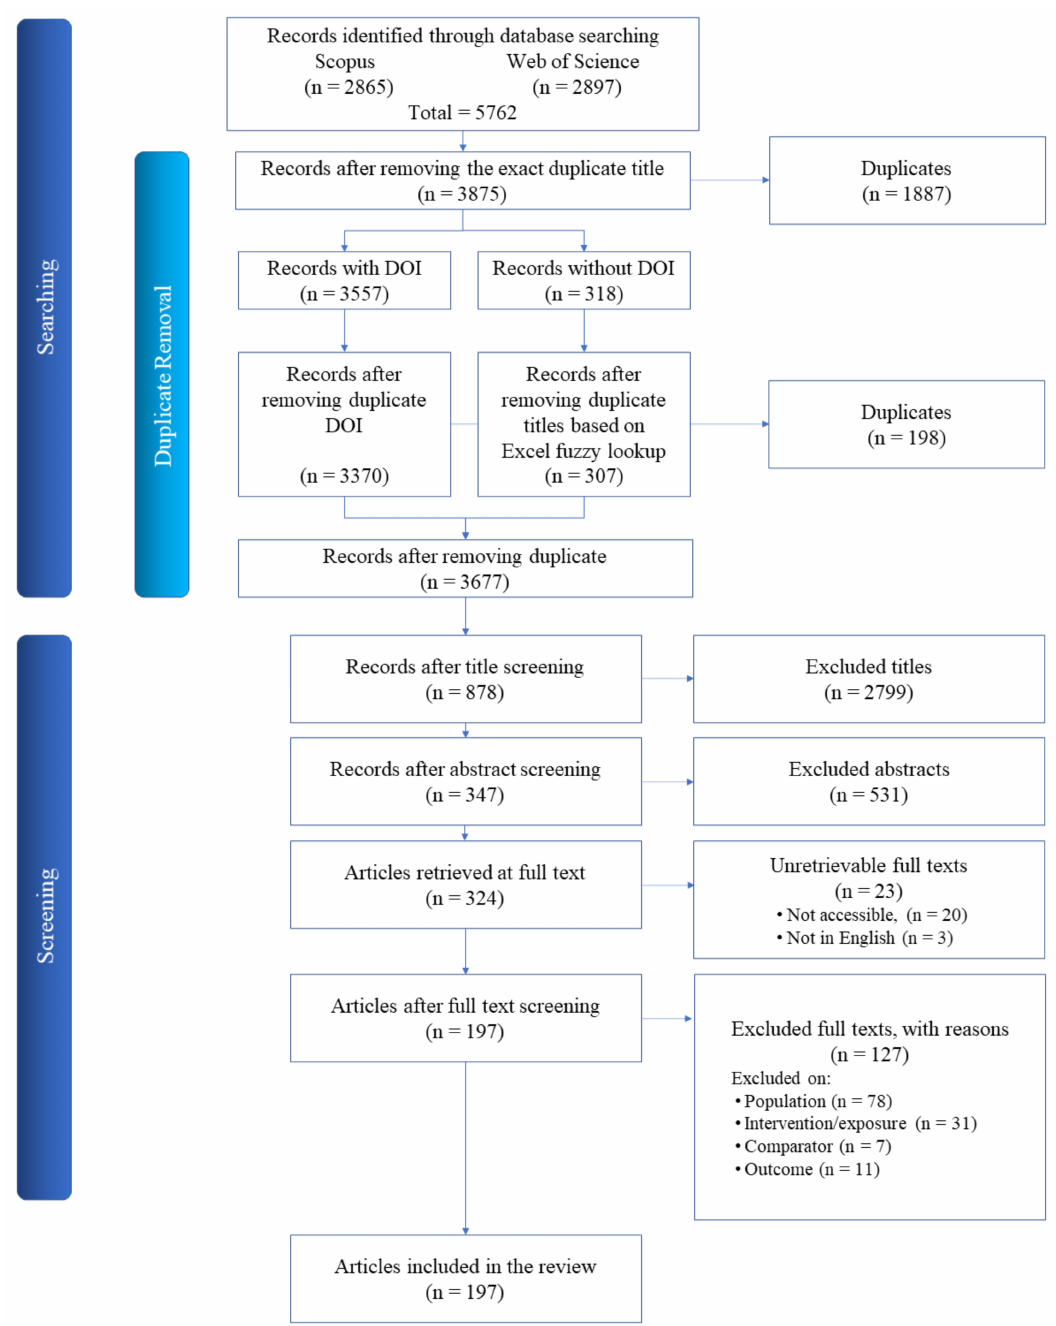
Figure 1. Flow diagram of the systematic